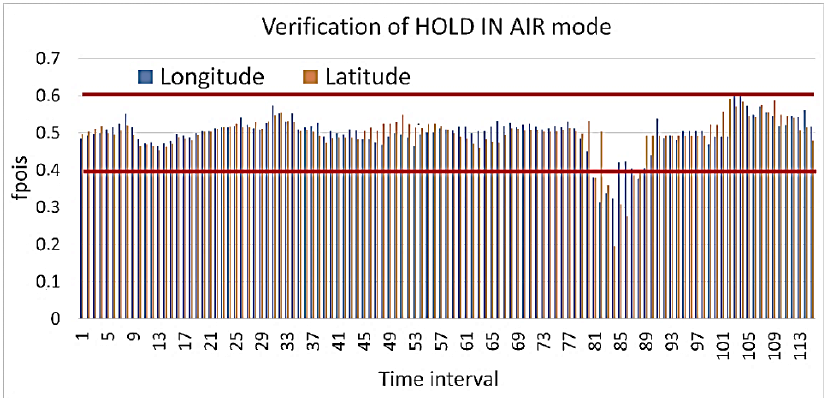
Figure 5. Verification of the HOLD IN AIR mode calculation of the cumulative function for the Poisson distribution.